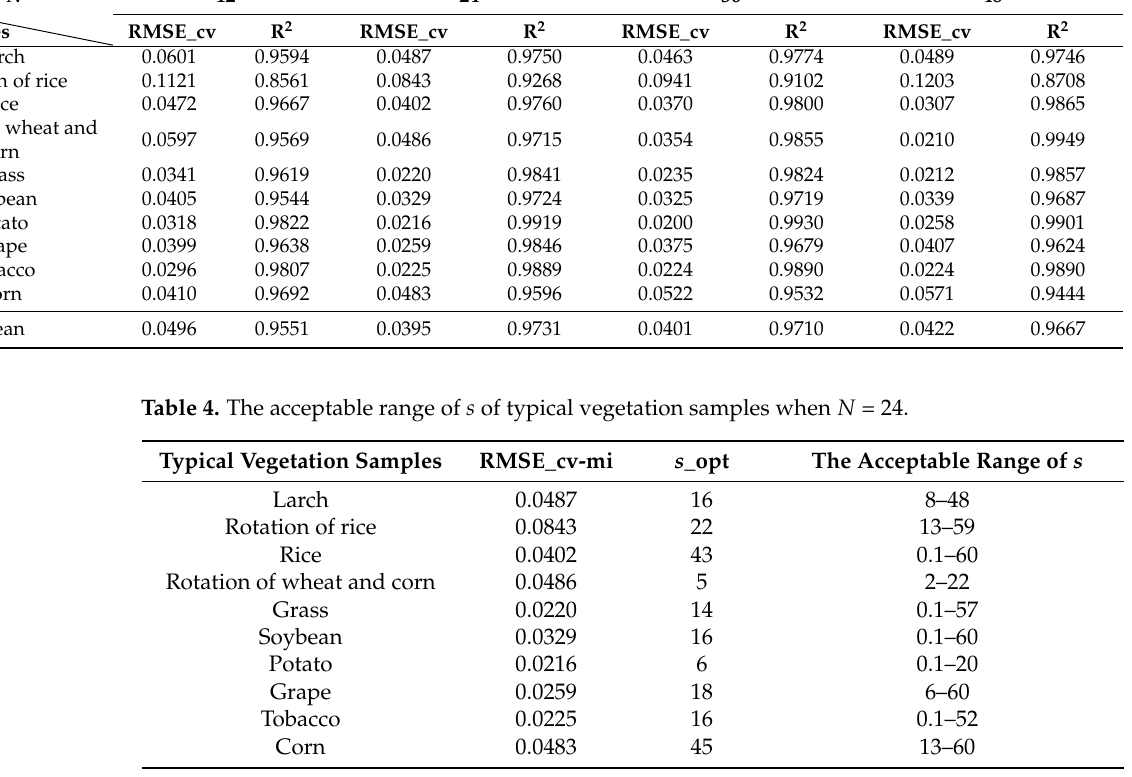
Vegetation Samples